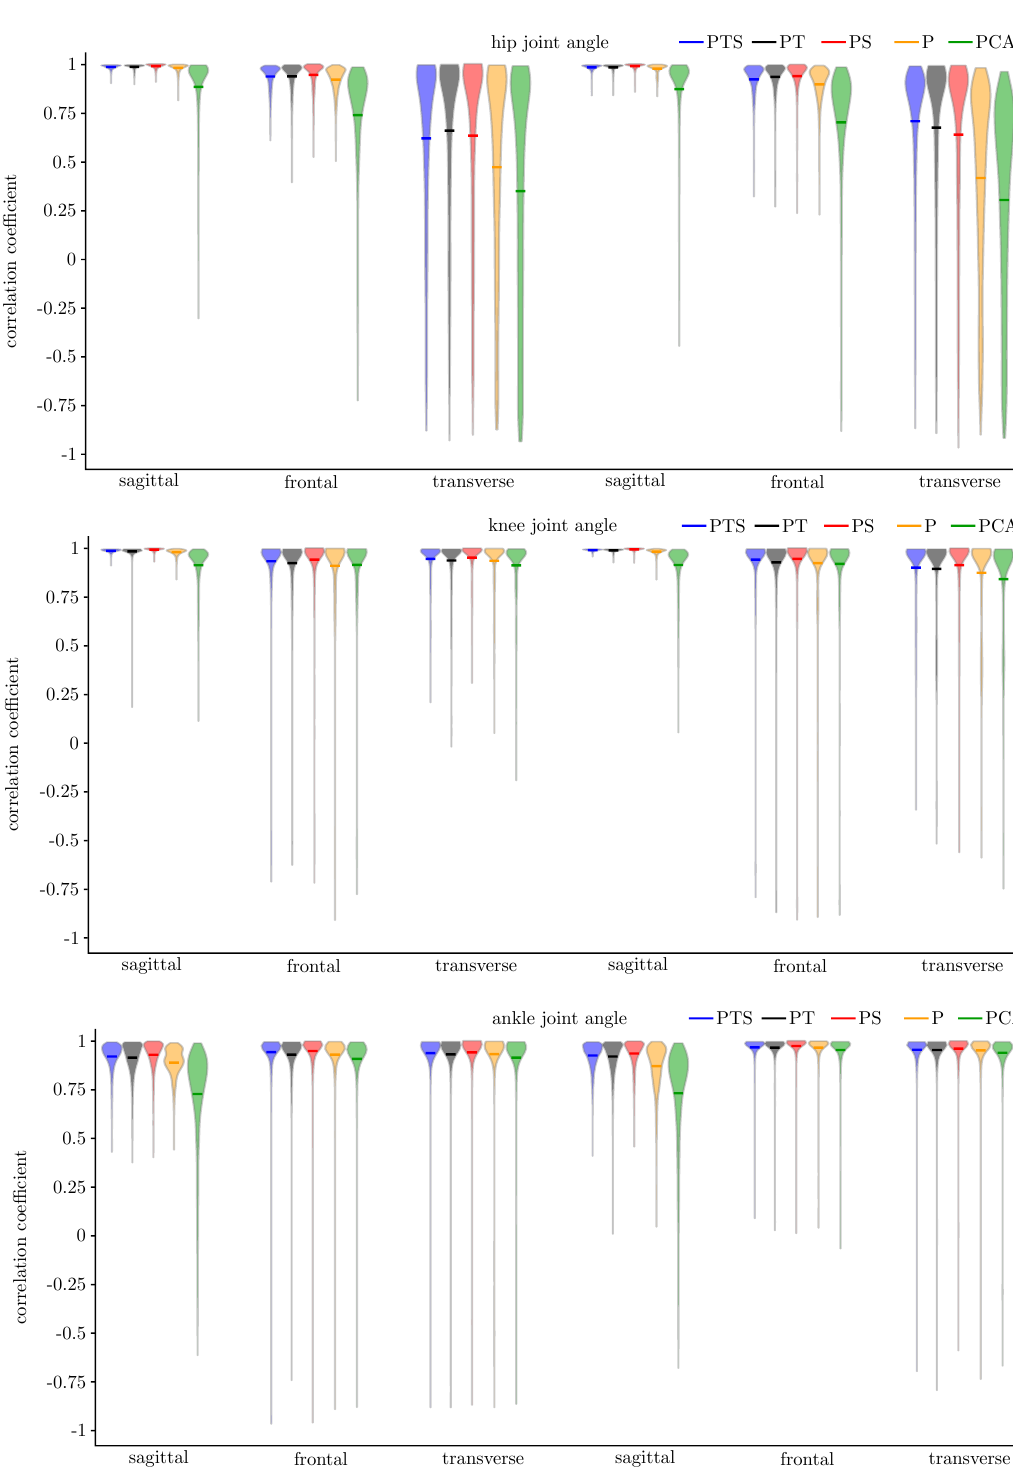
Figure 8. Distribution of the correlation coefficient for the ( Top ) Hip, ( Middle ) Knee and ( Bottom ) Ankle joint angle